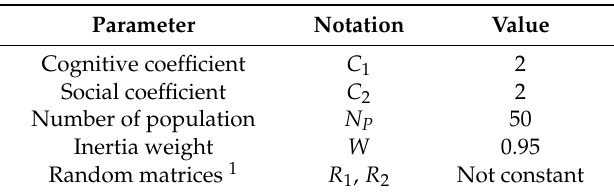
Table 3. Parameters of